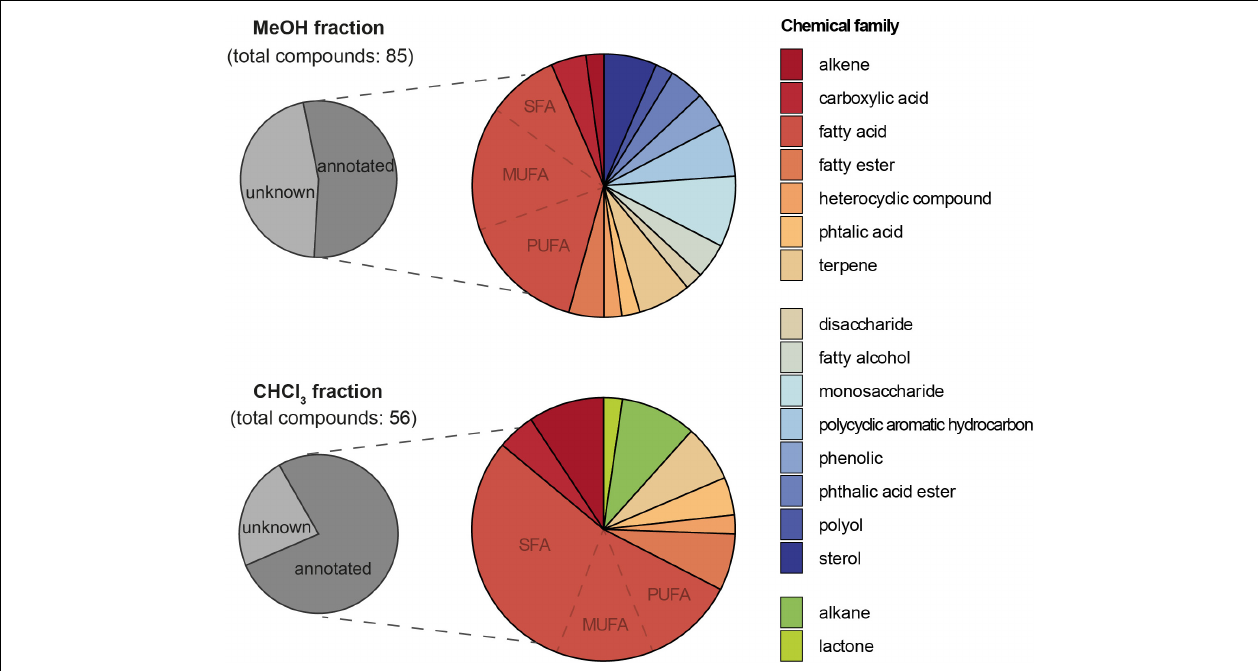
FIGURE 3 | Pie charts showing the proportions (from the total number of detected compounds) of annotated compounds and their chemical family in the MeOH and CHCl 3 fractions analyzed by